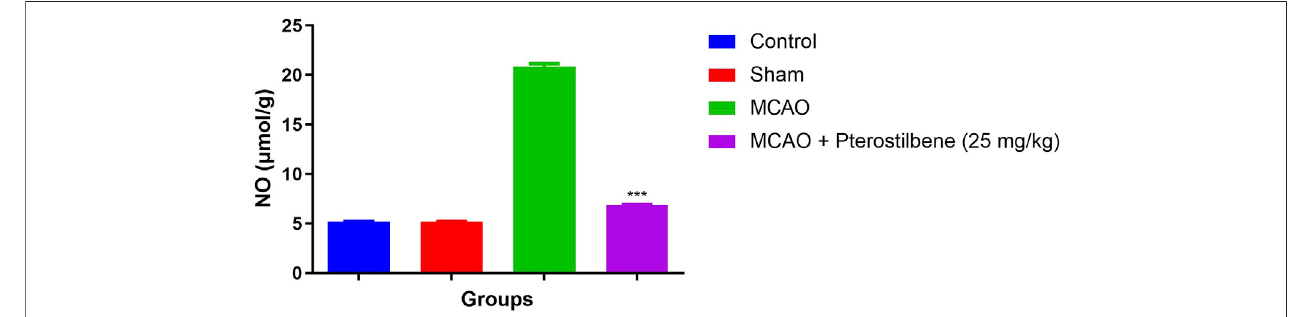
FIGURE7| showedthelevelofnitricoxideofamongexperimental groups.Values areexpressed asmean ± SEM.The t -testwasused forthesigni fi cantdifference between groups: * p < 0.05, ** p < 0.01, *** p < 0.005. NS, non-signi fi cant.